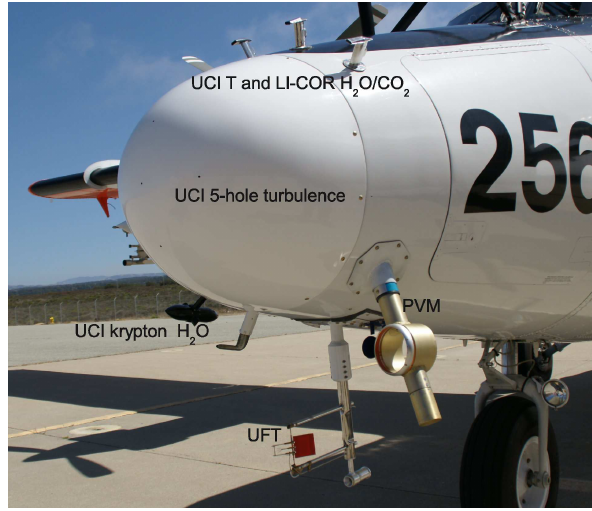
Fig. 1. Radome of CIRPAS Twin Otter research aircraft with fast-response instruments used in POST. figure